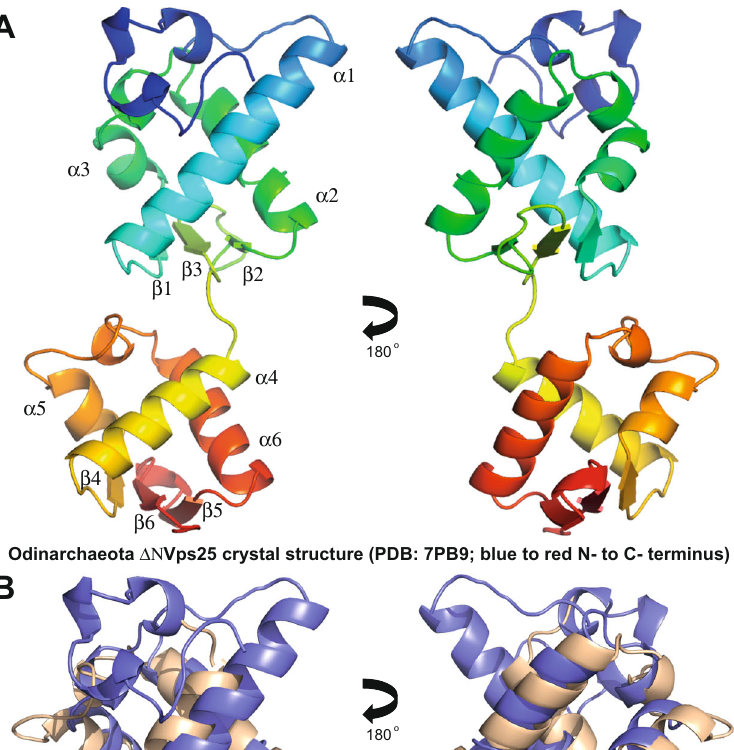
Alignment of Odinarchaeota Vps25 N- and C-terminal